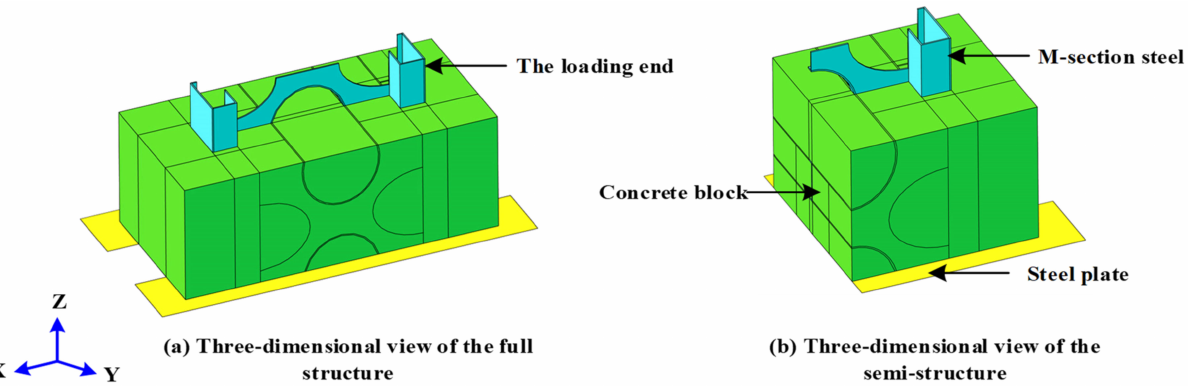
Figure 16. Finite element model.